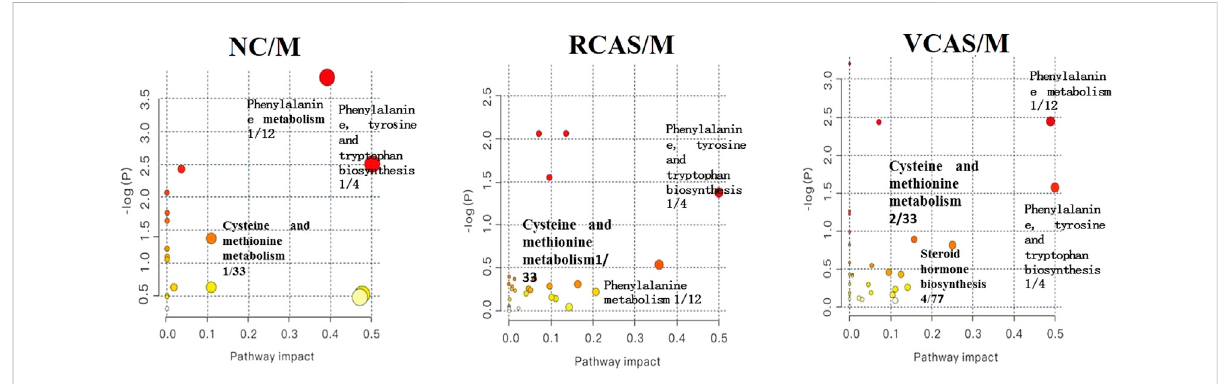
FIGURE 8 Enrichment results of metabolic pathways between urine